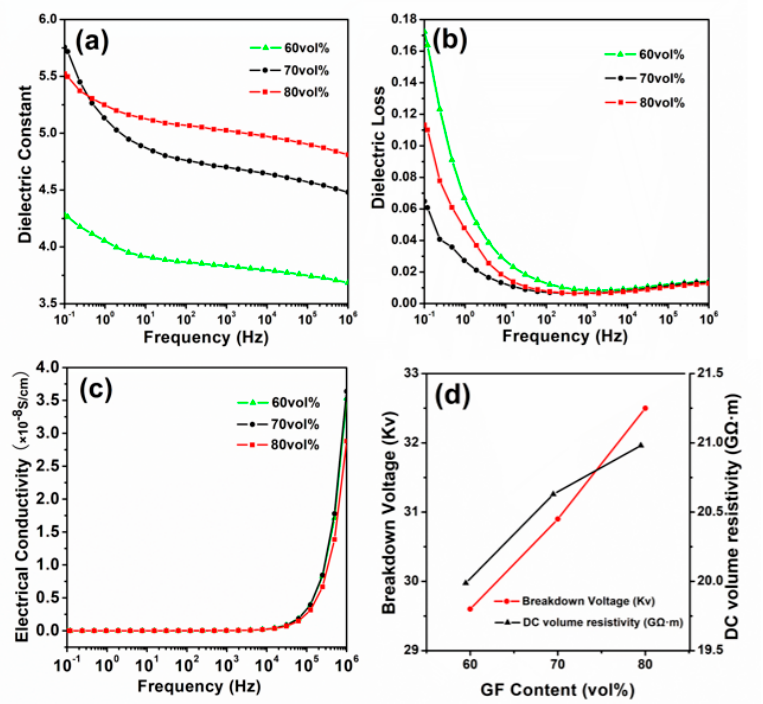
Figure 9. The ( a ) dielectric constant, ( b ) dielectric loss, ( c ) electrical conductivity, and ( d ) breakdown voltage and DC volume resistivity of the composites changed with fiber content and frequency at room temperature.